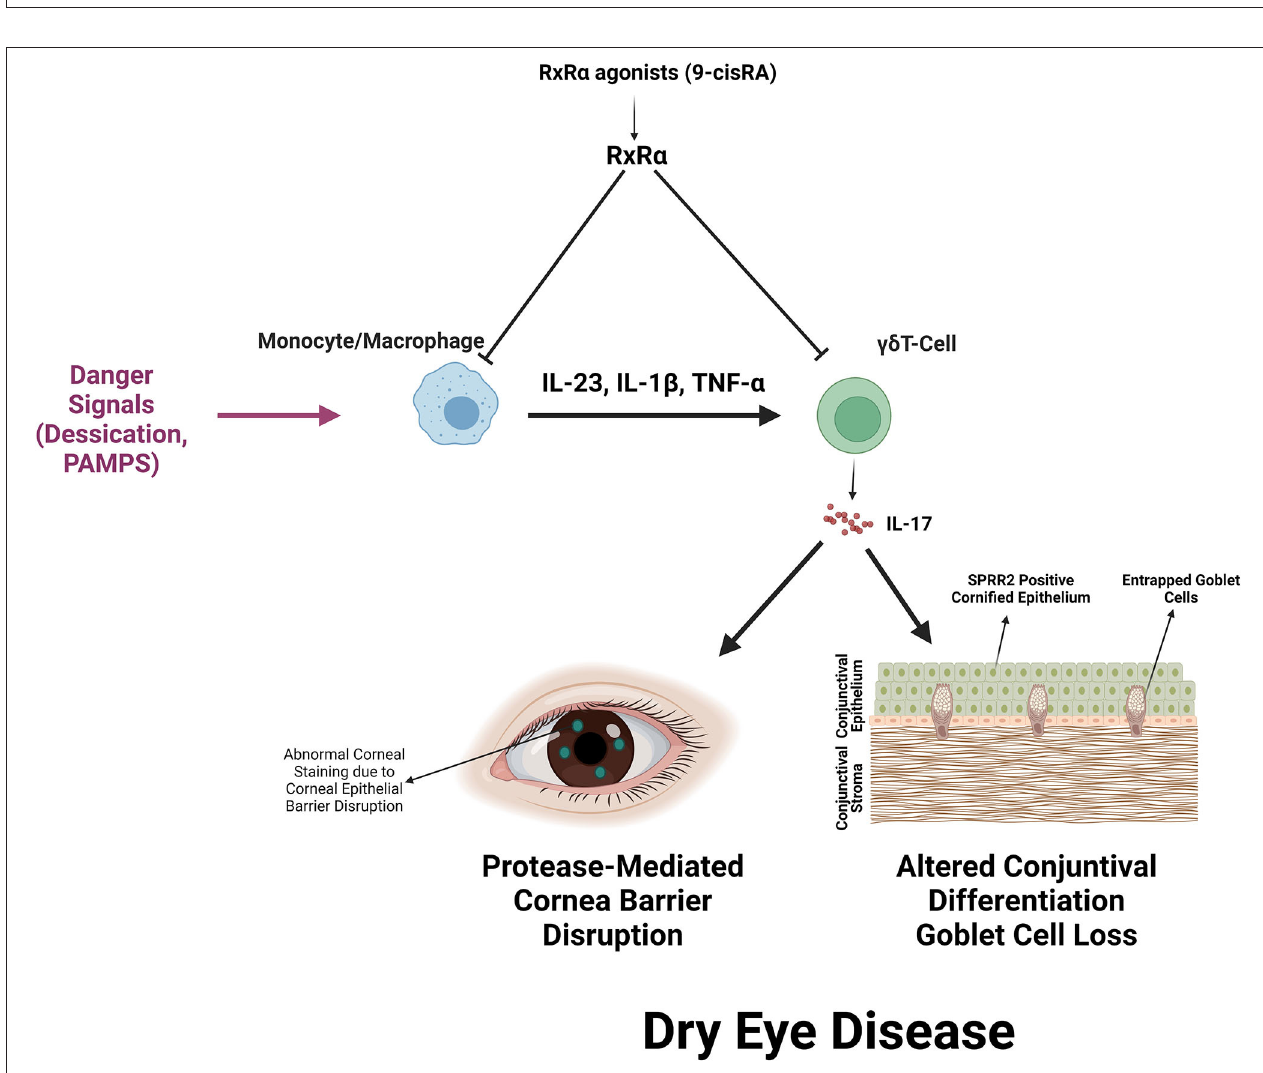
FIGURE 7 | lines indicate < or > 1.5 log 2 fold change and horizontal lines indicate genes with an adjusted p > 0.05. Red dots are genes that are significantly increased in Pinkie NC vs. B6 NC (left) or in Pinkie UC vs. Pinkie NC (left). Labeled genes in the left plot are found in the IL-17 signaling pathway. (C) Heat maps generated from the NanoString array of IL-17 pathway genes. (D) Fold change of expression level of factors involved in the pathogenesis of corneal vascularization ( Vegfa , Tnf , Fgf7) or corneal ulceration ( Mmp9 ) measured by RT-PCR. Values are mean ± SD ( n = 4/sample). (E) Immunostaining of blood (CD31) and lymphatic (LyVE-1) endothelial cell markers in 25- and 60-week-old B6 and Pinkie corneas. Arrows indicate corneal epithelium. ( n = 4/sample). * p < 0.01; ** p < 0.001; **** p < 0.0001.